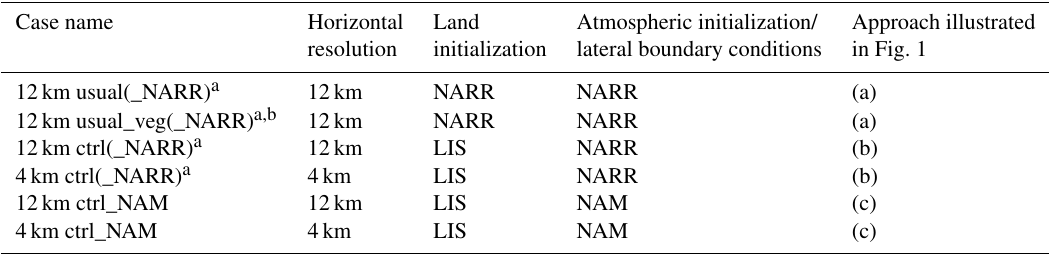
Table 1. Summary of all NUWRF simulations in this study. More descriptions of these simulations can be found in Fig. 1 and Sect. 2.1.3. Control is denoted by ctrl. Case name Horizontal Land